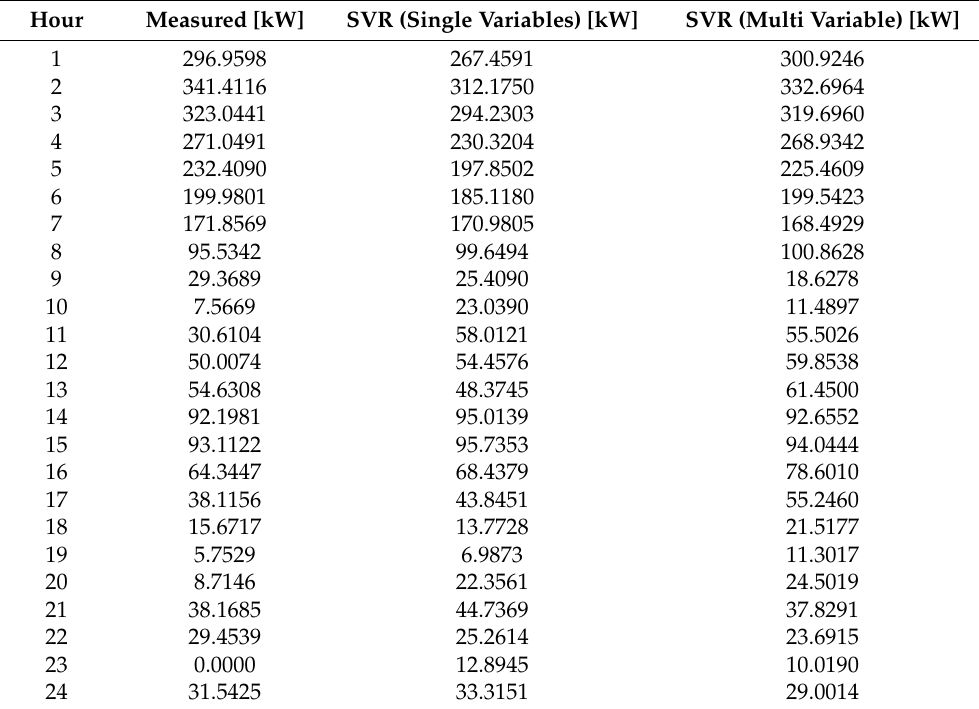
Table A1. Measured and forecasted wind power outputs on 8 January 2016.